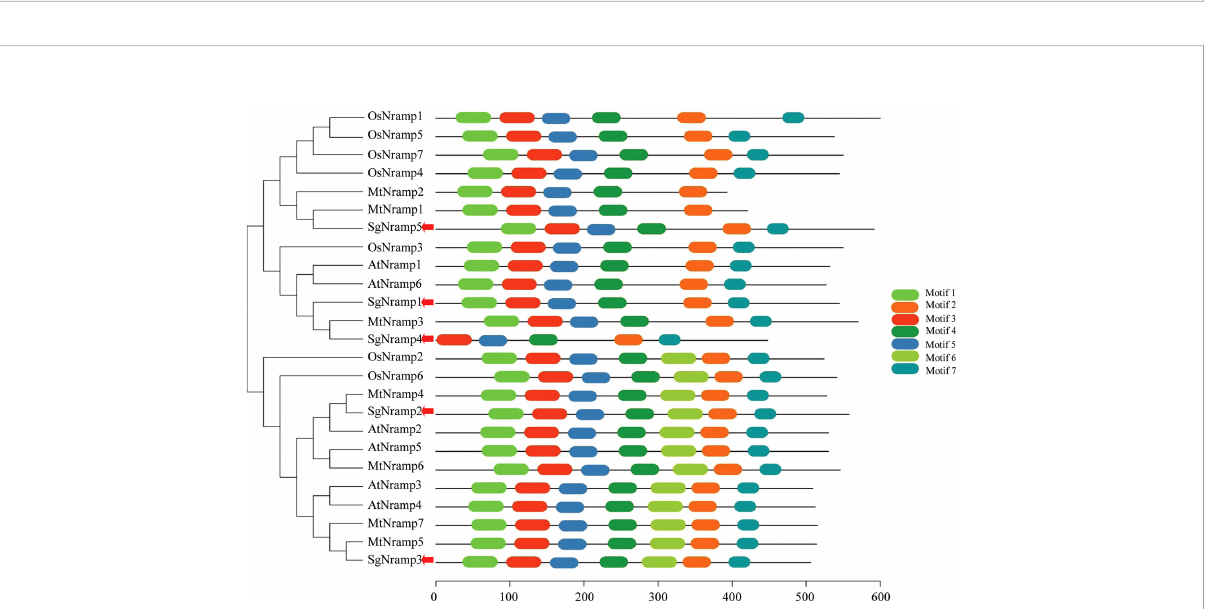
FIGURE 2 Phylogenetic analysis and conserved motifs of Nramp proteins in stylo and other plants. The fi rst two letters of each Nramp member indicate the plant species. At, Arabidopsis thaliana ; Os, Oryza sativa ; Mt, Medicago truncatula . The red arrows indicate SgNramps from stylo. The sequences of Nramp proteins were obtained from the previous studies (Tejada-Jime ́ nez et al., 2015; Qin et al., 2017; Mani and Sankaranarayanan, 2018). The phylogenetic tree was constructed by MEGA4. Conserved motifs of Nramp proteins were analyzed by MEME. Each motif is presented by a colored box. The sequences of different motifs of Nramp proteins were summarized in Supplementary Table S3.